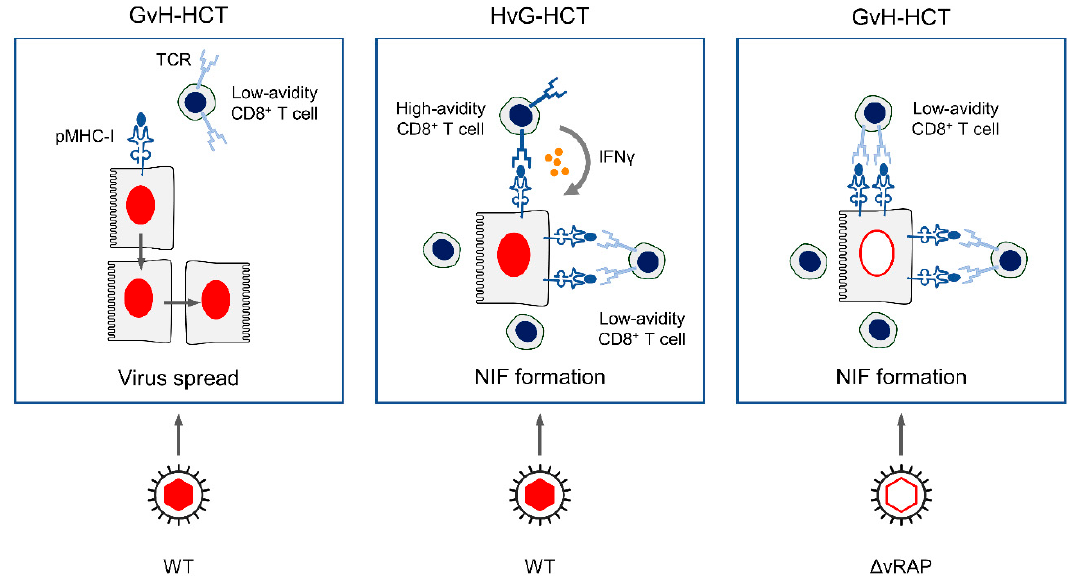
Figure 4. Graphical abstract. pMHC-I, peptide-loaded MHC-I molecules. TCR, T cell-receptor. NIF, nodular inflammatory focus, a microanatomical structure formed by CD8 + T cells that recognize infected tissue cells, here represented by hepatocytes. WT, wild-type mCMV. ∆ vRAP, mCMV with deletion of genes coding for viral regulators of antigen presentation (vRAP) that inhibit cell surface trafficking of pMHC-I complexes. Adapted from reference